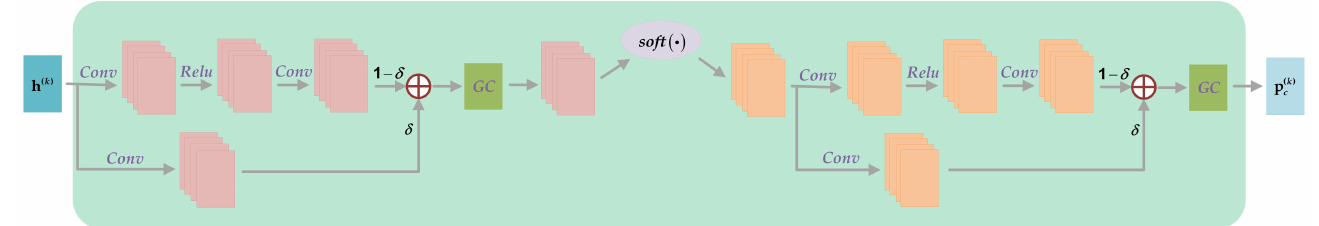
Figure 3. The CNN module in the kth